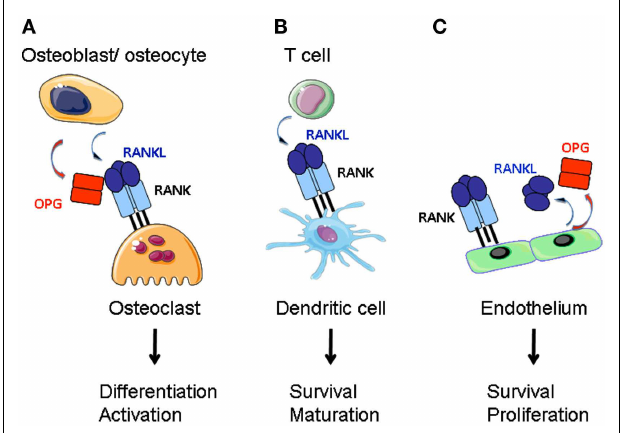
FIGURE 1 | RANKL function in the bone, the adaptive immune system and the vascular system. (A) RANKL produced by bone marrow stroma (osteoblasts and osteocytes) directs the differentiation of preosteoclasts of the myeloid lineage into mature osteoclasts. Stroma-derived OPG negatively regulates RANKL-RANK interaction. (B) ActivatedT cells express RANKL that stimulates dendritic cell survival and maturation. (C) Endothelium is a source for RANKL and OPG. RANK-activation of endothelial cells supports cell survival and promotes